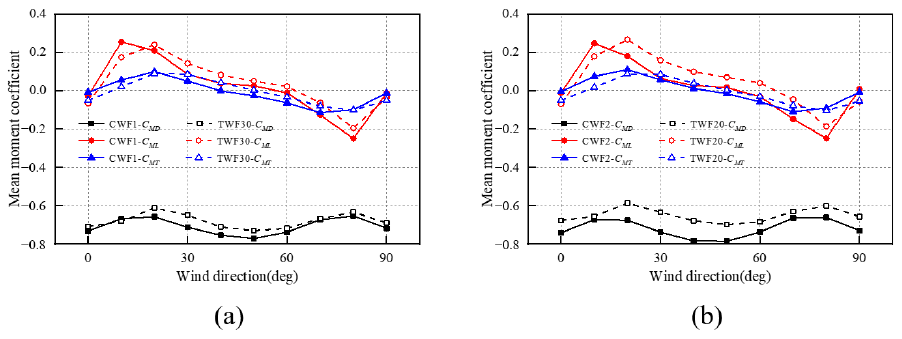
Figure 15. Variations of C MD , C ML , C MT with θ ref : ( a ) TWF30 and CWF1; and ( b ) TWF20 and CWF2.